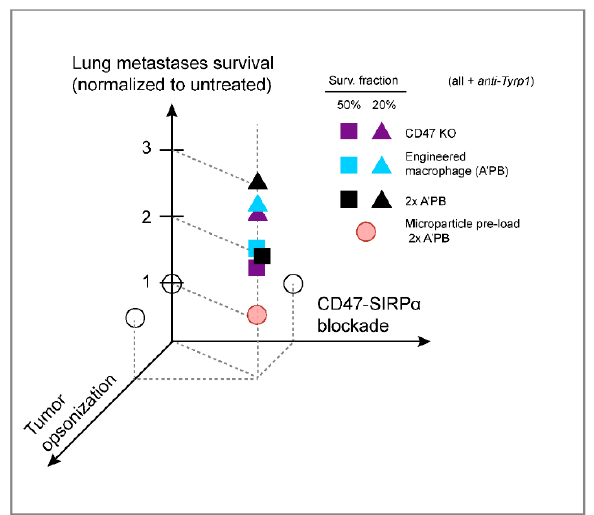
Figure 8. Summary of lung metastases results shows need for combination therapy. Schematic of survival results, with CD47-SIRP α disruption and tumor opsonization extending survival in combination, but not separately based on statistical significance. Each point is representative of median (square: 50% survival) or 80th percentile (triangle: 20% survival) survival time for the indicated group and is normalized to the survival of the untreated.